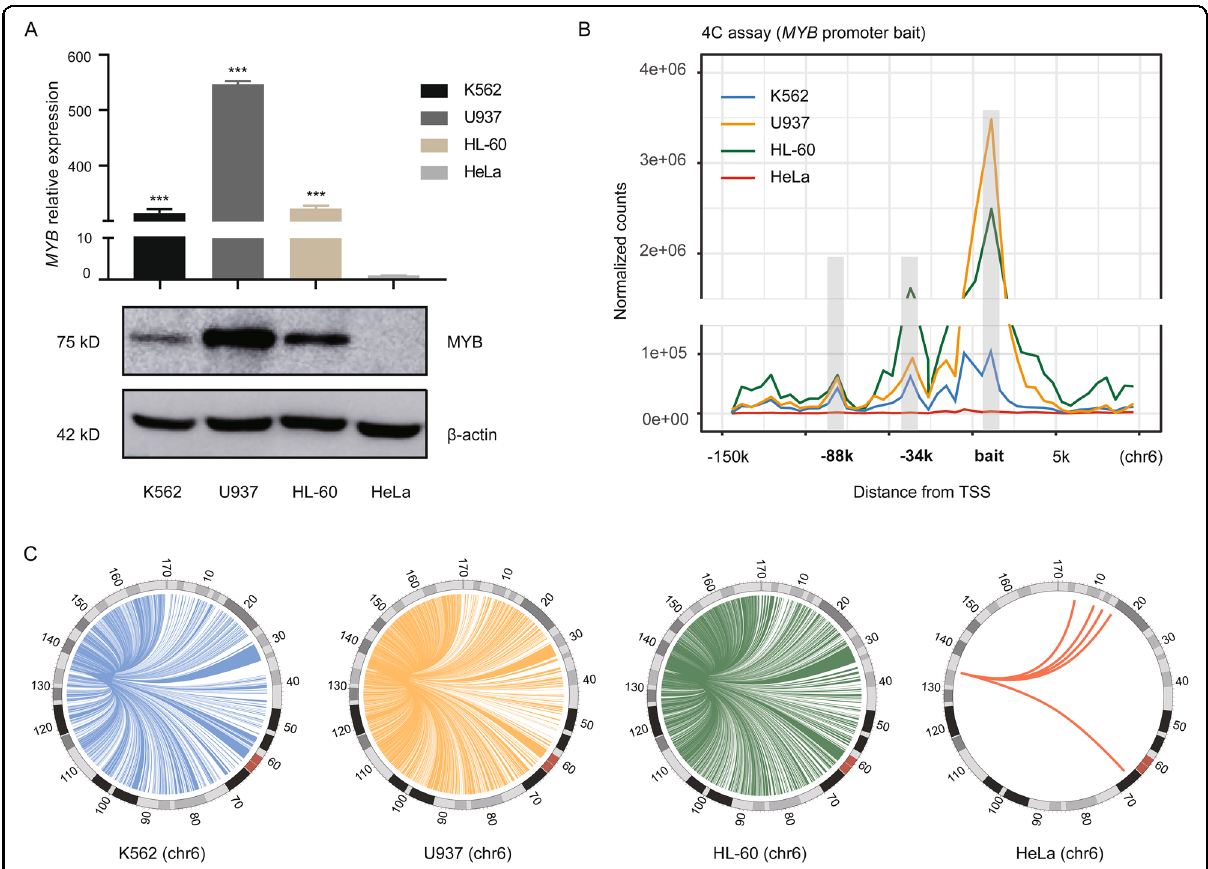
Fig. 1 Long-range interaction between the MYB promoter and its upstream distal regions in human myeloid leukemia cells. A MYB mRNA (upper) and protein (lower) levels were determined in K562, U937, HL-60, and HeLa cell lines, using RT-qPCR and Western blot respectively. Gapdh was used as an internal control, β -actin was used as a loading control. Data are represented as mean ± SD of three independent experiments, and P values are calculated using Student ’ s t -test (* P < 0.05; ** P < 0.01; *** P < 0.001). B 4C assay was performed with the MYB promoter as viewpoint in indicated cells. The diagram shows the near-bait interactions on chromosome 6 in indicated cells, the distribution plot of normalized read counts was generated by the 4C-ker to visualize proximity of the peaks to the bait. Upstream regions showing high frequency of interaction are highlighted. Distance of indicated regions from transcription start site (TSS) is shown. C Circos diagrams depicting the 4C-seq contact map for intra-chromosomal interactions in indicated cell lines called by